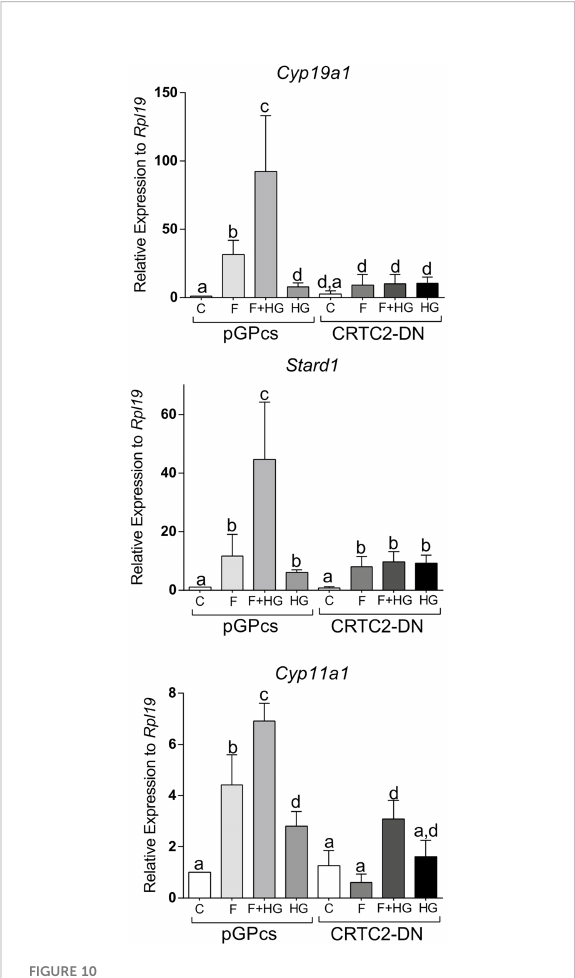
FIGURE 10 Dominant negative CRTC2 inhibits FSH and SIK inhibition effects. Rat GCs were infected 2 h after plating with lentivirus carrying an empty plasmid (pGPcs) or CRTC2-DN. 24 h later, cells were treated with FSH (50 ng/ml) in the presence of vehicle or HG (0.5 µM). Cyp19a1 , Stard1 , and Cyp11a1 mRNA levels were determined 48 h after adding FSH. One-way ANOVA followed by Tukey. Columns labeled with different letters differ signi fi cantly a-b, a-d, and b-c, p < 0.05; a-c p < 0.01, n =